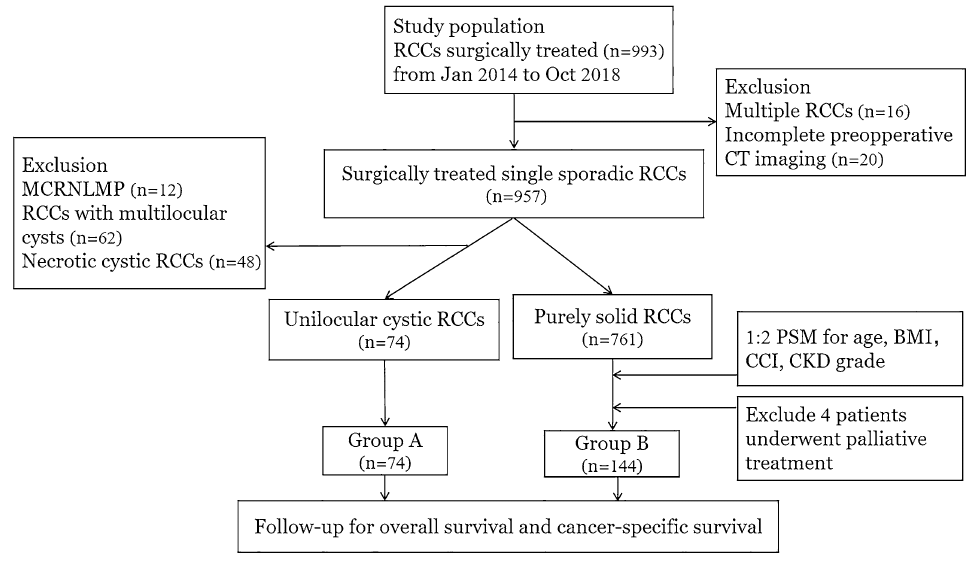
Figure 1. Flowchart of enrolling